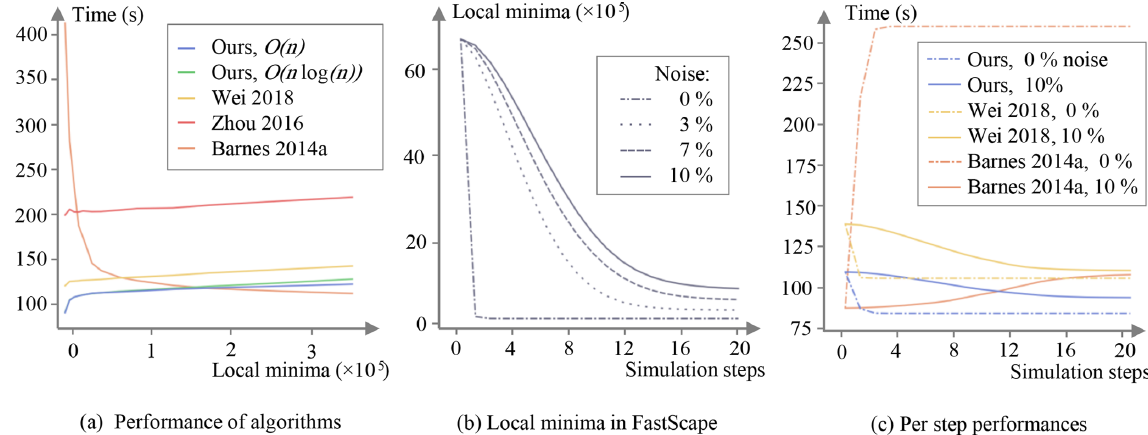
Figure 5. Results from benchmarks assessing the performance of our algorithm for local minima resolution – including both O ( n log n ) Kruskal’s and O ( n ) Mareš’ variants for computing the minimum spanning tree, compared to three other solutions based on variants of the Priority-Flood depression filling algorithm proposed by Barnes et al. (2014a), Zhou et al. (2016), and Wei et al. (2018). See text for more details about the setup of these benchmarks. (a) Execution time measured for local minima resolution applied once to a synthetic input topography vs. total number of local minima generated in the input topography. (b) Evolution of the number of local minima detected in the topography obtained at each of the first 20 time steps of a FastScape model run. Each curve corresponds to a given magnitude of random perturbations added to produce spatially variable uplift rates (magnitude values are relative to a fixed uplift rate of 5 × 10 − 3 m yr − 1 ). (c) Execution time measured for local minima resolution at each time step, with either spatially uniform or variable uplift rates (i.e., a relative noise magnitude of either 0% or 20%). The blue curves refer to our algorithm using the O ( n ) variant for computing the minimum spanning